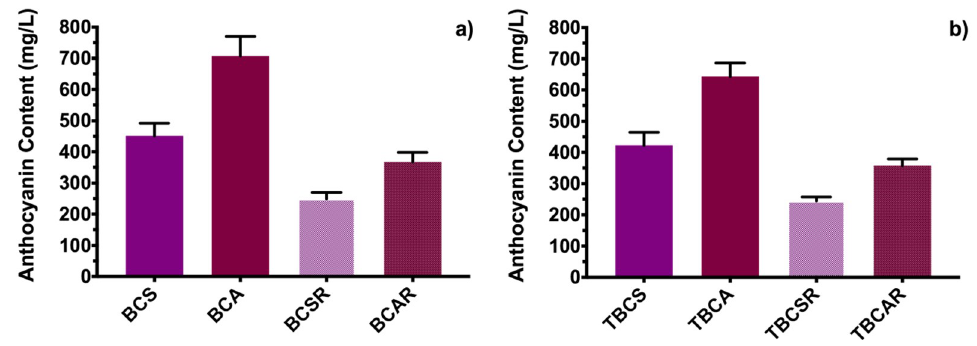
Figure 3. Anthocyanin content in black carrot extracts. ( a ) Samples extracted with ethanol/citric acid